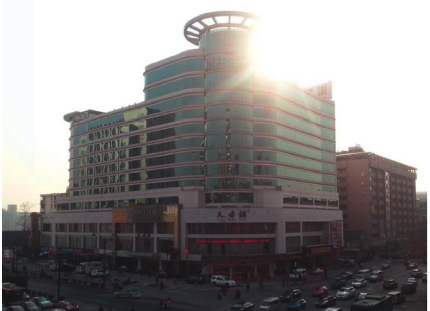
Figure 1: Scene photo of the existing high-rise building.